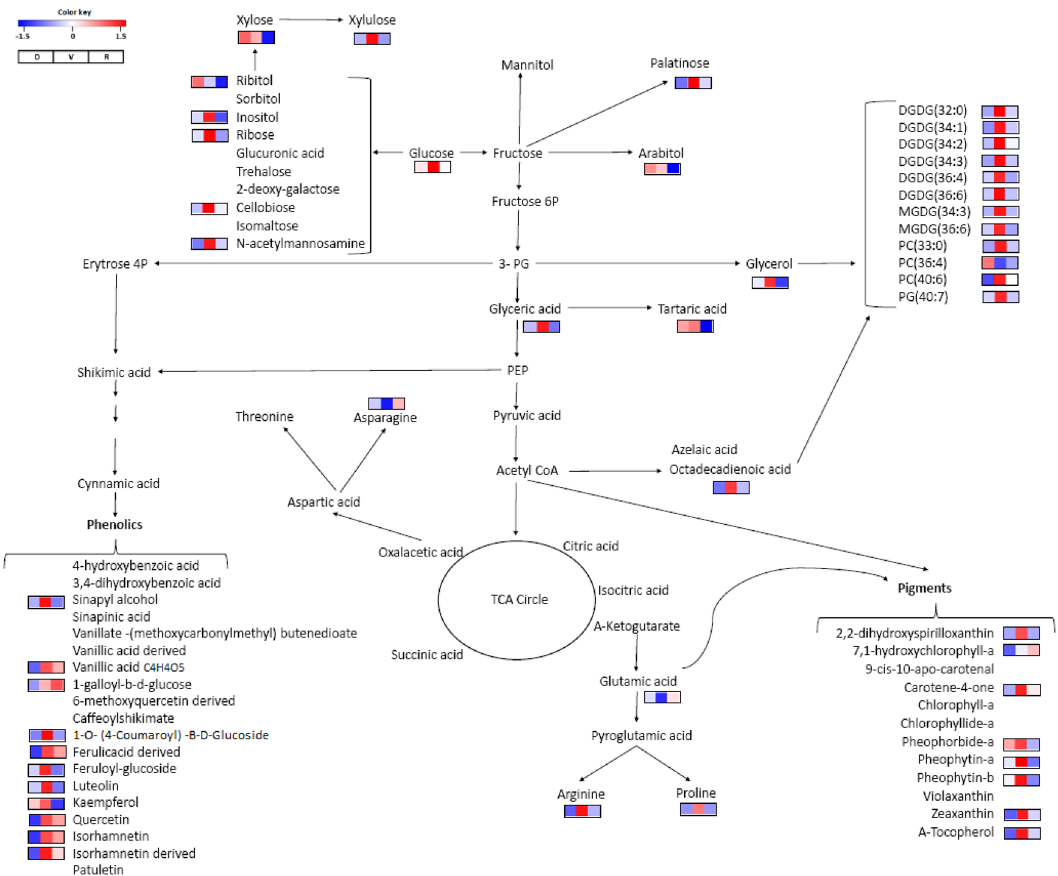
Figure 8. Metabolic pathway indicating the annotated metabolites of Gomphrena agrestis Mart. leaves in a rock- field area in the dry and rainy seasons. Bars indicate relative intensity of metabolites, with pairwise comparisons of higher changes between the sample groups R × D and R × V. D dry period, V veranico period, R rainy